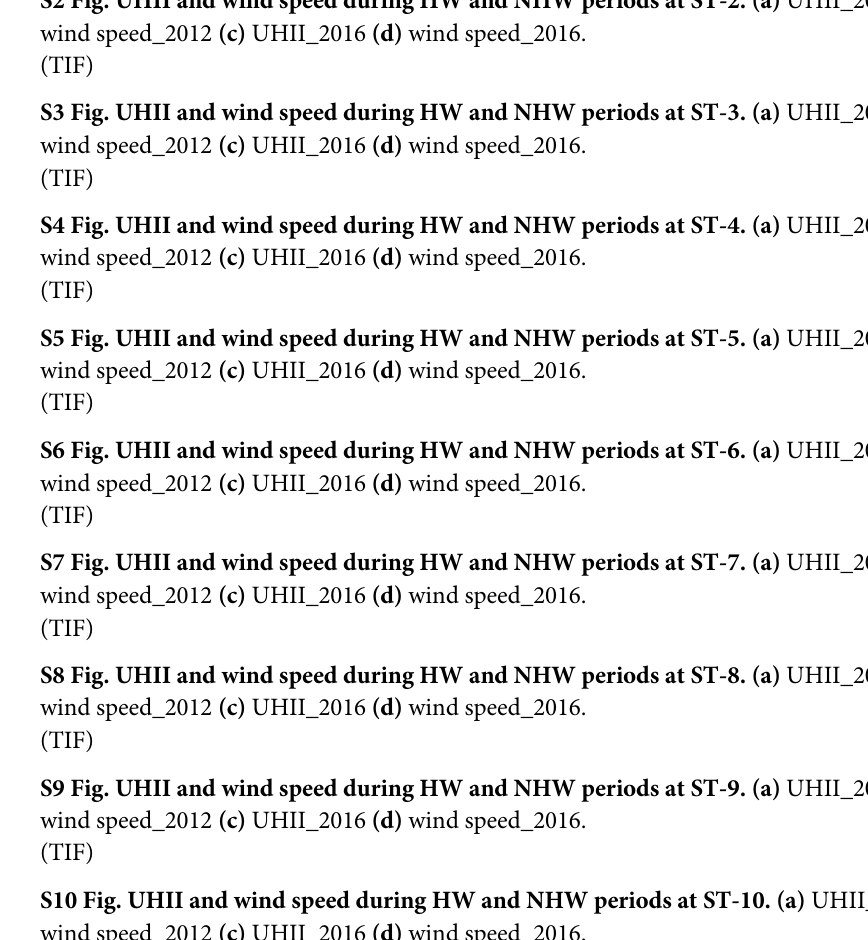
S2 Fig. UHII and wind speed during HW and NHW periods at ST-2. (a) UHII_2012 (b) wind speed_2012 (c) UHII_2016 (d) wind speed_2016. (TIF) S3 Fig. UHII and wind speed during HW and NHW periods at ST-3. (a) UHII_2012 (b) wind speed_2012 (c) UHII_2016 (d) wind speed_2016. (TIF) S4 Fig. UHII and wind speed during HW and NHW periods at ST-4. (a) UHII_2012 (b) wind speed_2012 (c) UHII_2016 (d) wind speed_2016. (TIF) S5 Fig. UHII and wind speed during HW and NHW periods at ST-5. (a) UHII_2012 (b) wind speed_2012 (c) UHII_2016 (d) wind speed_2016. (TIF) S6 Fig. UHII and wind speed during HW and NHW periods at ST-6. (a) UHII_2012 (b) wind speed_2012 (c) UHII_2016 (d) wind speed_2016. (TIF) S7 Fig. UHII and wind speed during HW and NHW periods at ST-7. (a) UHII_2012 (b) wind speed_2012 (c) UHII_2016 (d) wind speed_2016. (TIF) S8 Fig. UHII and wind speed during HW and NHW periods at ST-8. (a) UHII_2012 (b) wind speed_2012 (c) UHII_2016 (d) wind speed_2016. (TIF) S9 Fig. UHII and wind speed during HW and NHW periods at ST-9. (a) UHII_2012 (b) wind speed_2012 (c) UHII_2016 (d) wind speed_2016. (TIF) S10 Fig. UHII and wind speed during HW and NHW periods at ST-10. (a) UHII_2012 (b) wind speed_2012 (c) UHII_2016 (d) wind speed_2016.